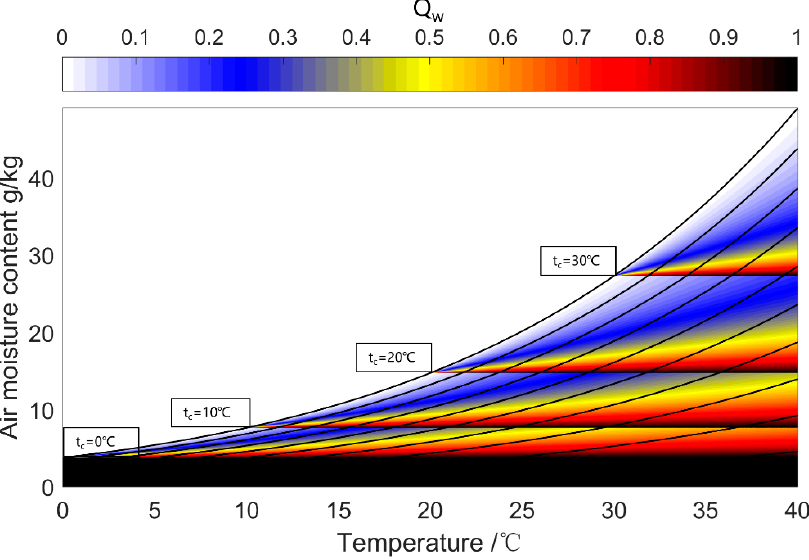
Figure 3. Q w , the ratio of energy consumption to reach saturation to total energy consumption.